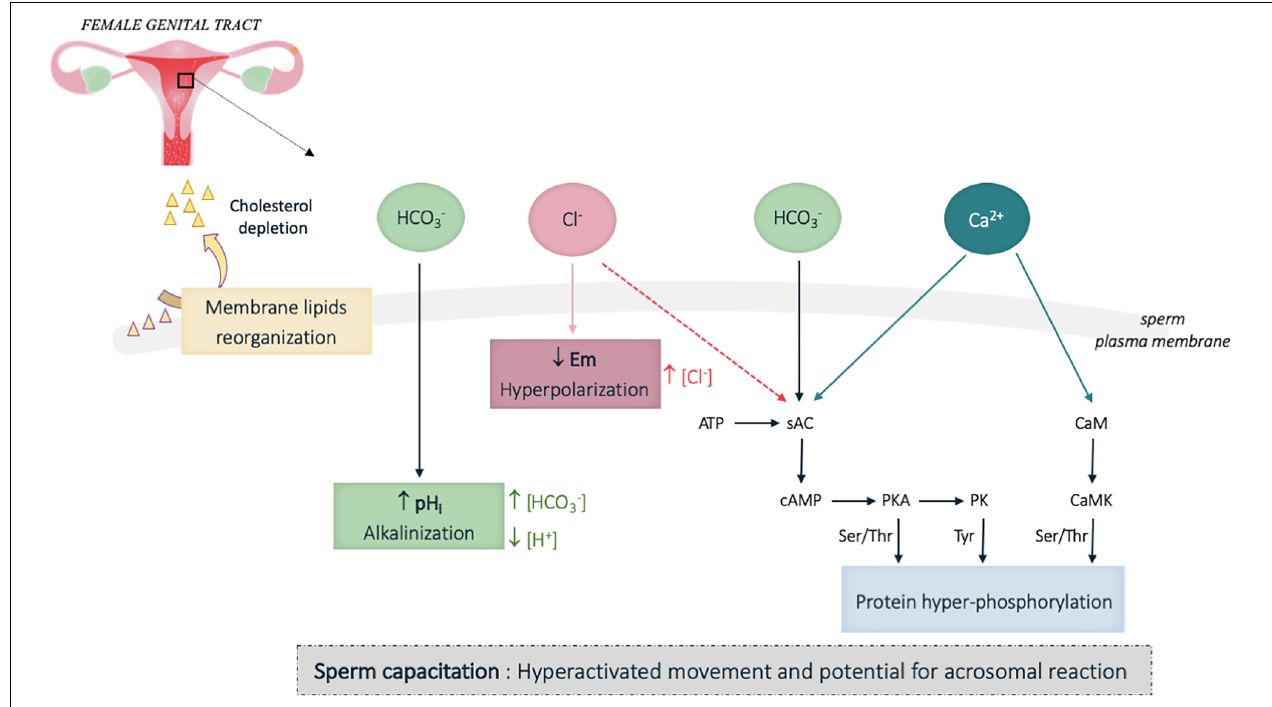
FIGURE 3 | Schematic representation of the biochemical and electrophysiological changes during sperm capacitation in the female genital tract. Capacitation confers the sperm cells a hyperactivated motility characterized by an increased flagellar amplitude and beating frequency, and the ability to perform the acrosomal reaction and to specifically recognize and interact with oocyte. This functional activation is mainly induced by HCO 3 − , Ca 2 + and Cl − influxes, which trigger biochemical and electrophysiological changes in the cytoplasm and the whole plasma membrane of the sperm cells. Among the principal changes, are observed an increase of the plasma membrane fluidity through cholesterol depletion, which favor the relocation of proteins located in the sperm head and involved in oocyte interaction, together with an alkalinization of the cytoplasm and plasma membrane hyperpolarization. Intense protein phosphorylation, which include some proteins involved in flagellar beating, is observed on the sperm flagellum. pH i , intracellular pH; Em, membrane potential; [ ... ], cytoplasmic ion concentrations; ↑ , increase; ↓ , decrease. Plain and broken arrows indicate a direct and indirect effect,